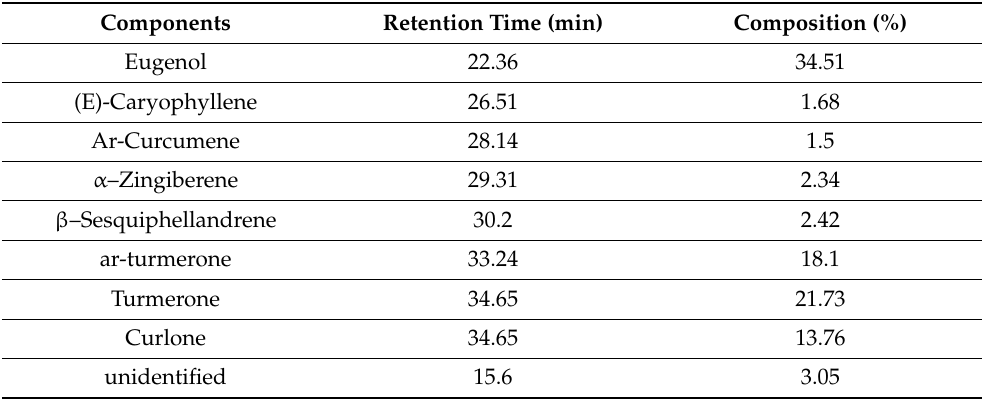
Table 2. Identification of Curcuma longa L. aqueous extract bioactive compounds.